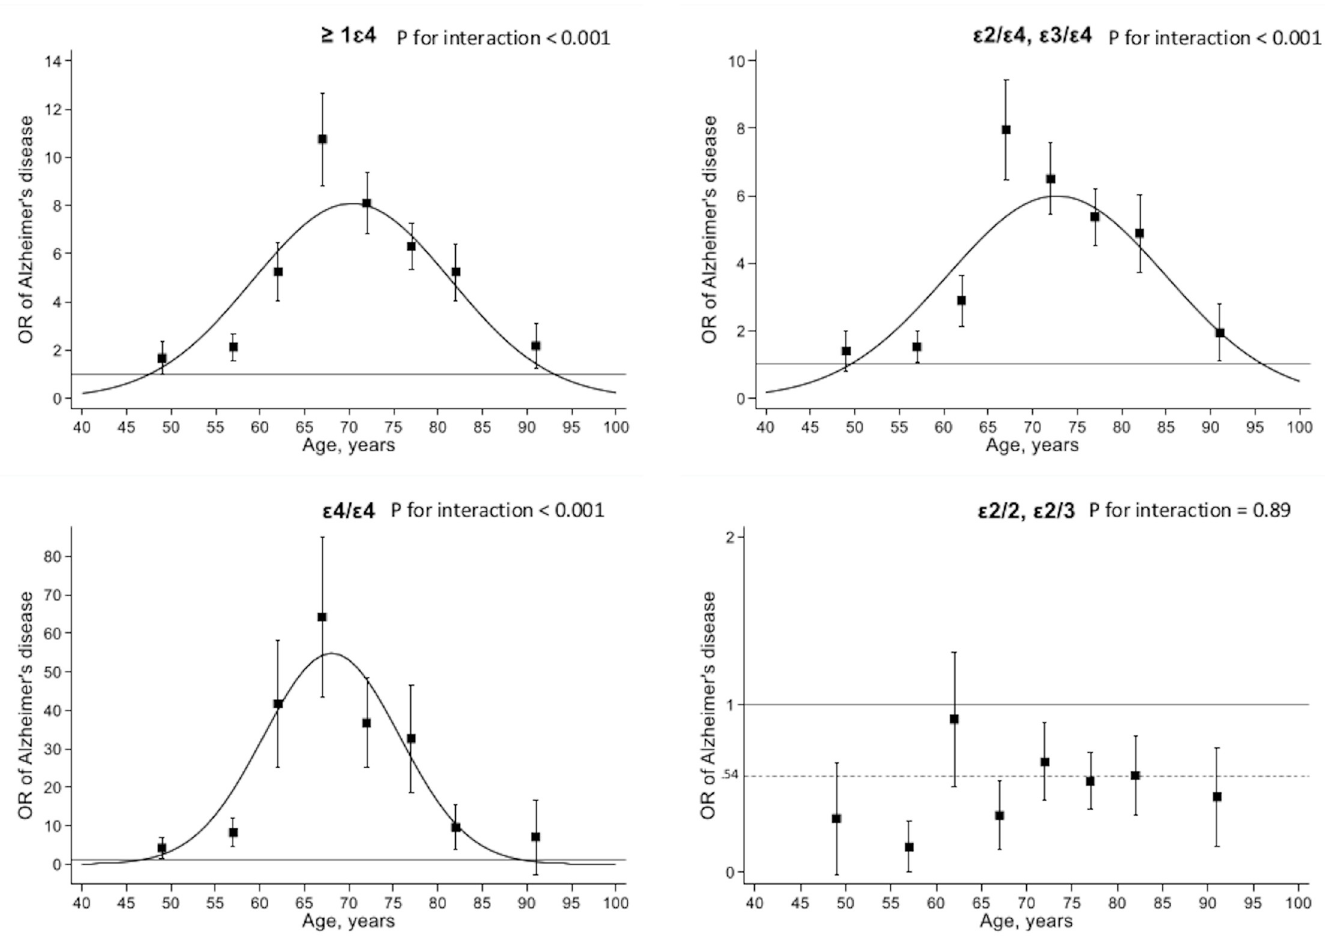
Fig 4. Association of APOE genotype in CSF-determined AD cases compared with population controls. Genotype ε 3/ ε 3 was used as reference. p -Value is for interaction between age 2 and APOE . Error bars correspond to the standard errors of the ORs calculated by 5-year age categories. Association between age and OR of AD (curves in the graphs) was modeled using a quadratic term for age in the logistic regression model and adjusted for sex and education. AD, Alzheimer disease; APOE , apolipoprotein E; CSF, cerebrospinal fluid; OR, odds ratio.